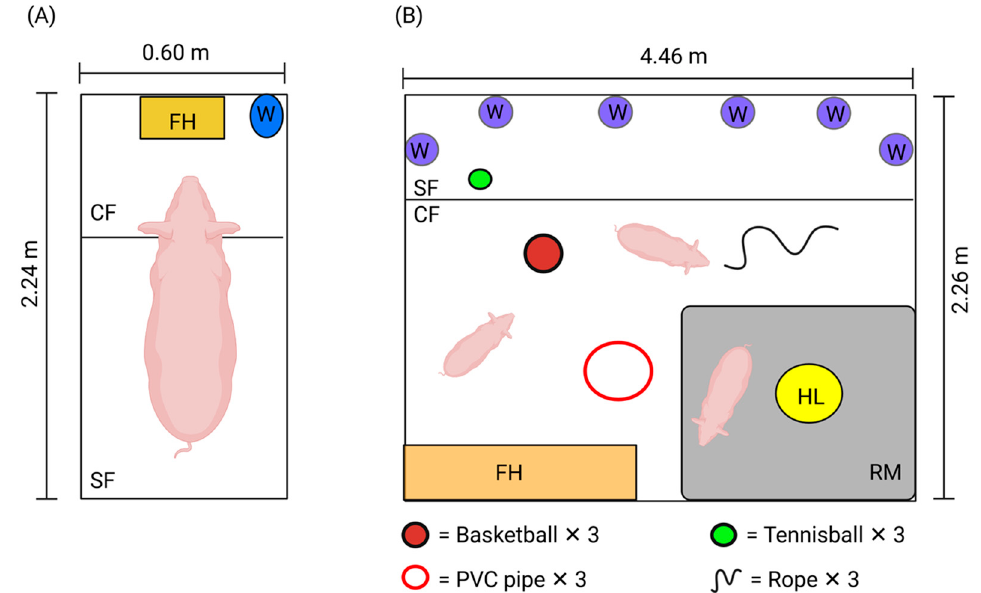
Figure 4. Indicates ( A ) barren housing (individually stalled, no human contact and no enrichment) and ( B ) enriched housing (group housed in pens, positive human interaction and enrichment provided). Barren housing conditions contained a feed hopper (FH), nipple drinker (W), concrete (CF), and slatted flooring (SF). Enriched housing contained a feed hopper (FH), nipple drinkers (W), concrete (CF), and slatted flooring (SF), a heat lamp (HL), rubber matting (RM) and enrichment materials (see legend in figure).